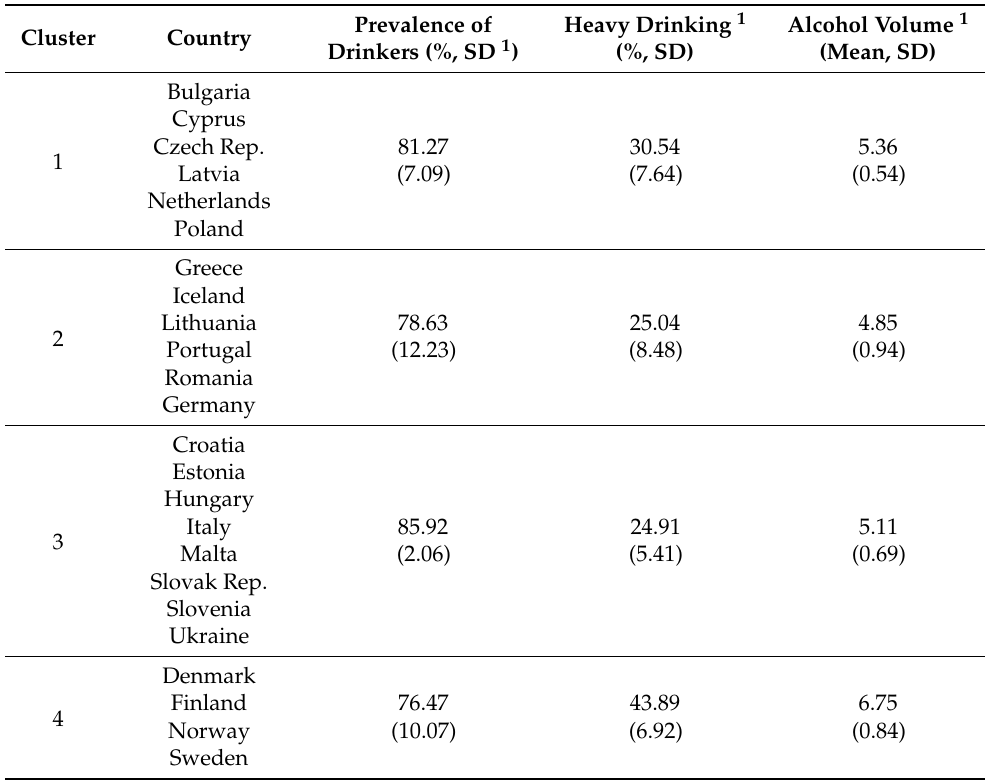
Table 4. Clusters by country and indicators of drinking for